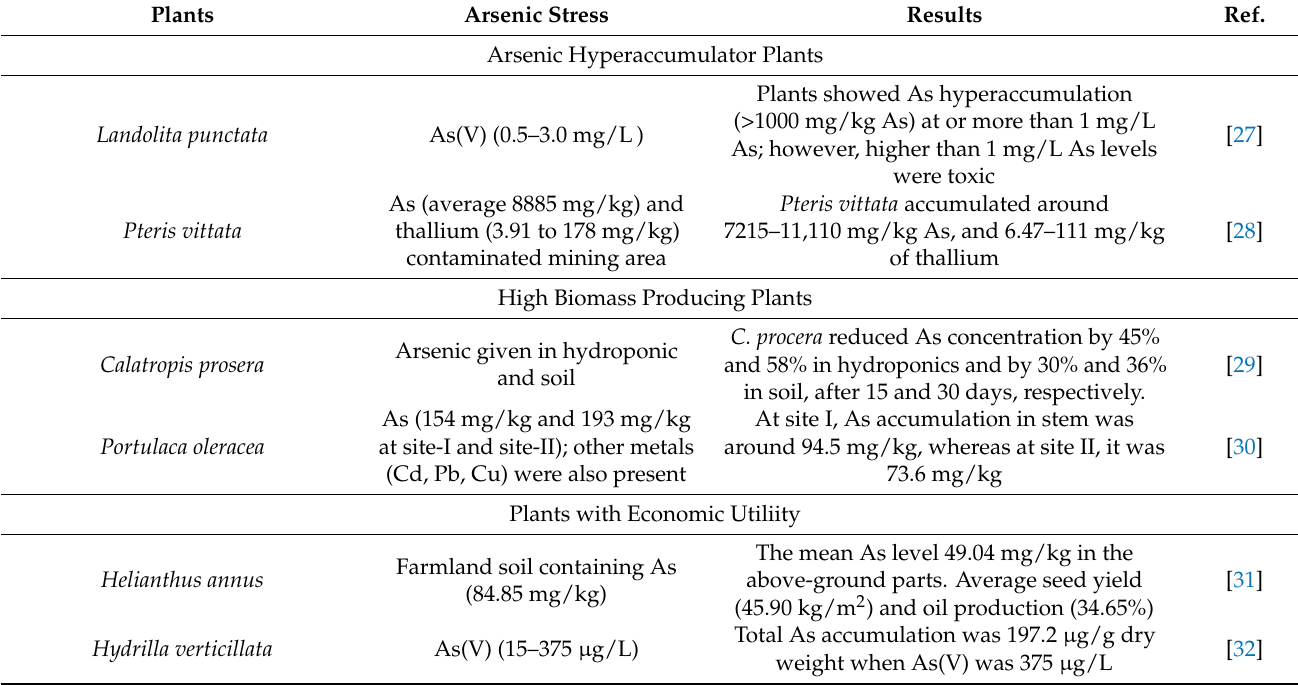
Figure 1. Various approaches to arsenic phytoremediation: use of hyperaccumulator plants or native high biomass and bioenergy plants; intercropping of arsenic accumulator plant with a crop plant for reduced arsenic toxicity to crop plant; microbe-or nanoparticle-assisted arsenic phytoremediation and the use of genetic engineering approaches to enhance phytoremediation potential of plants. Table 1. A summary of recent studies on various phytoremediation approaches.